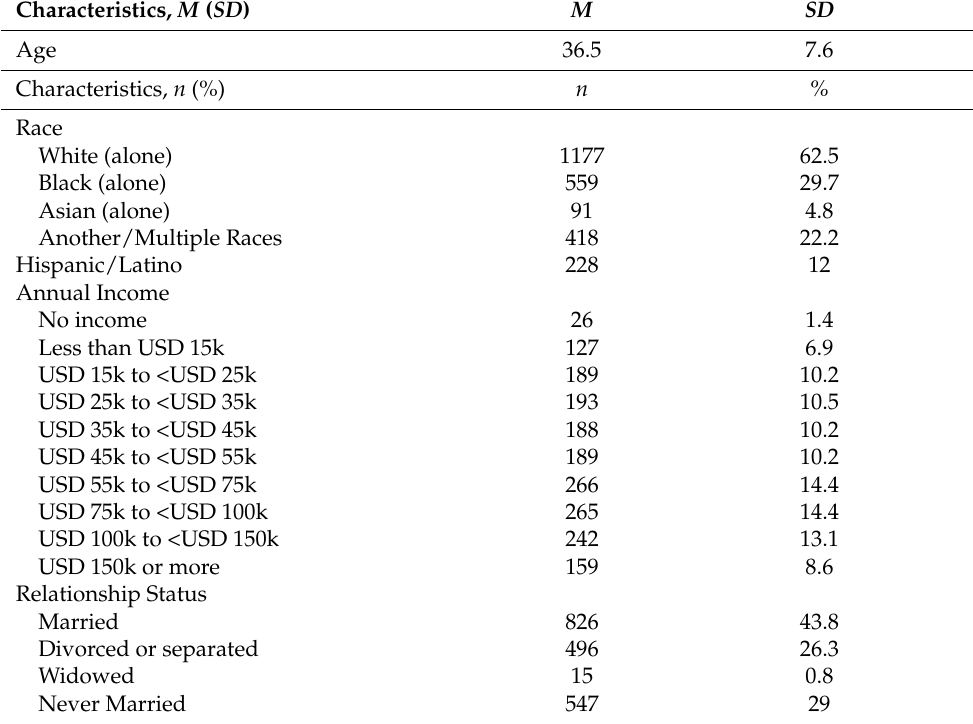
Table 1. Sample sociodemographic and military-related characteristics ( n = 1921).